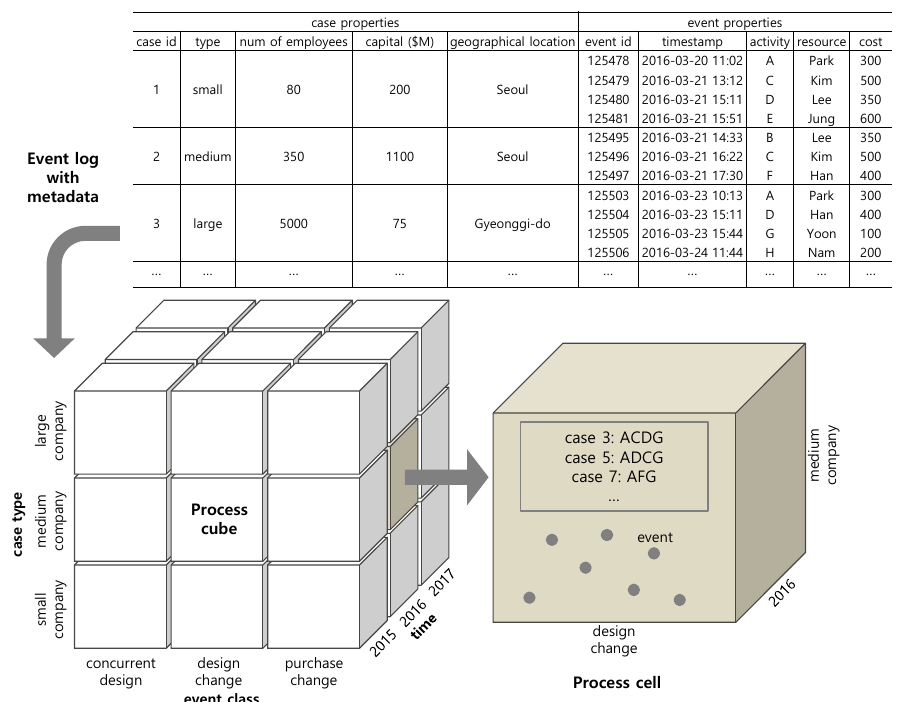
Figure 3. The design of a process cube for collaborative operational events between partners in supply chain management.